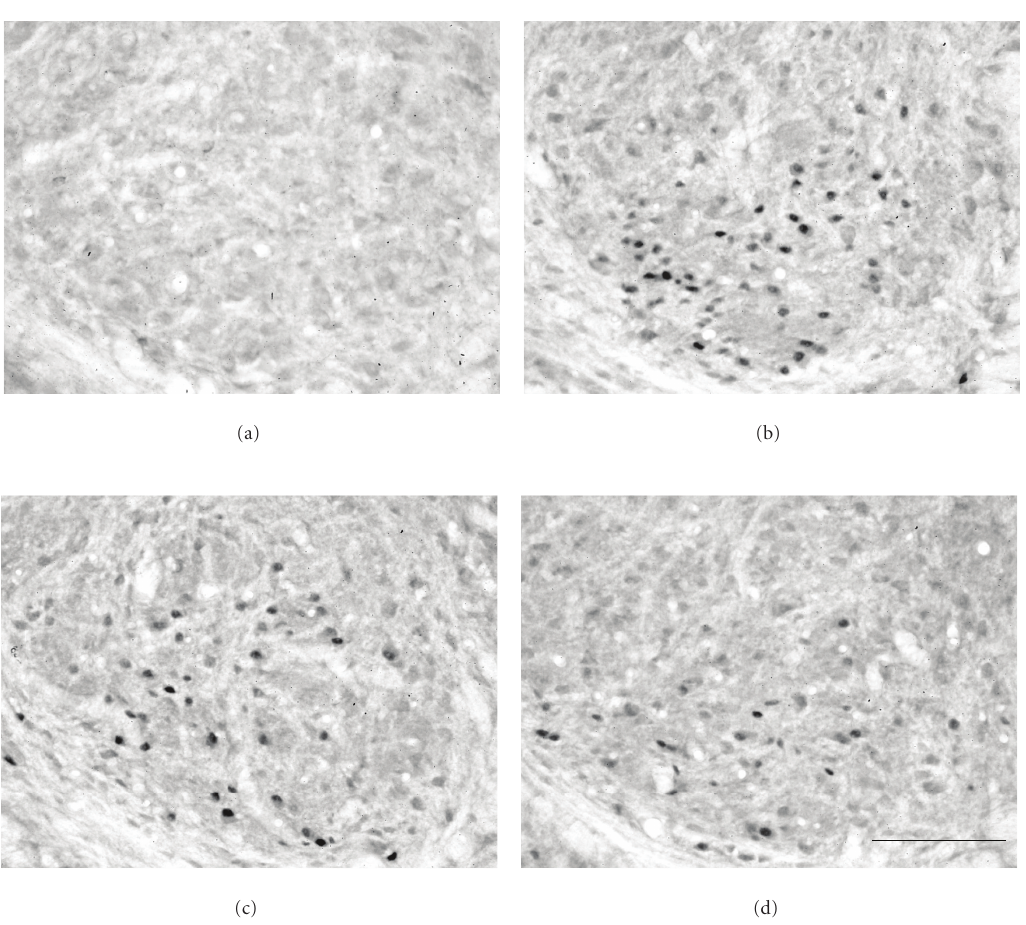
Figure 6: Photomicrographs showing c-Fos-LI cells in the middle region of the CN ipsilateral to electrical stimulation four weeks after chronic constriction injury in control (a), presaline (b), pre-1% lido (c) and pre-5% lido (d) groups. Bar = 100 μ